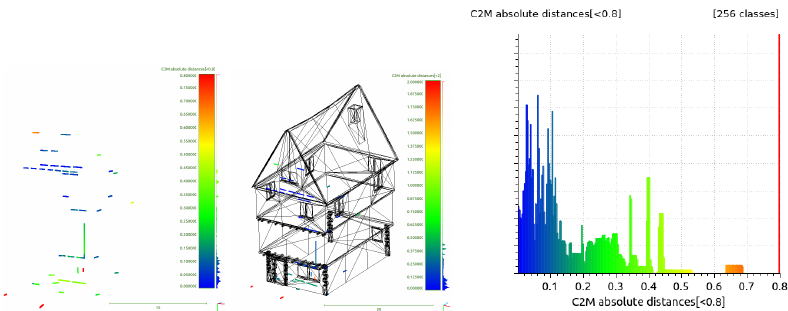
Figure 2. Results with the method Line3D++[12], using the same set of images as